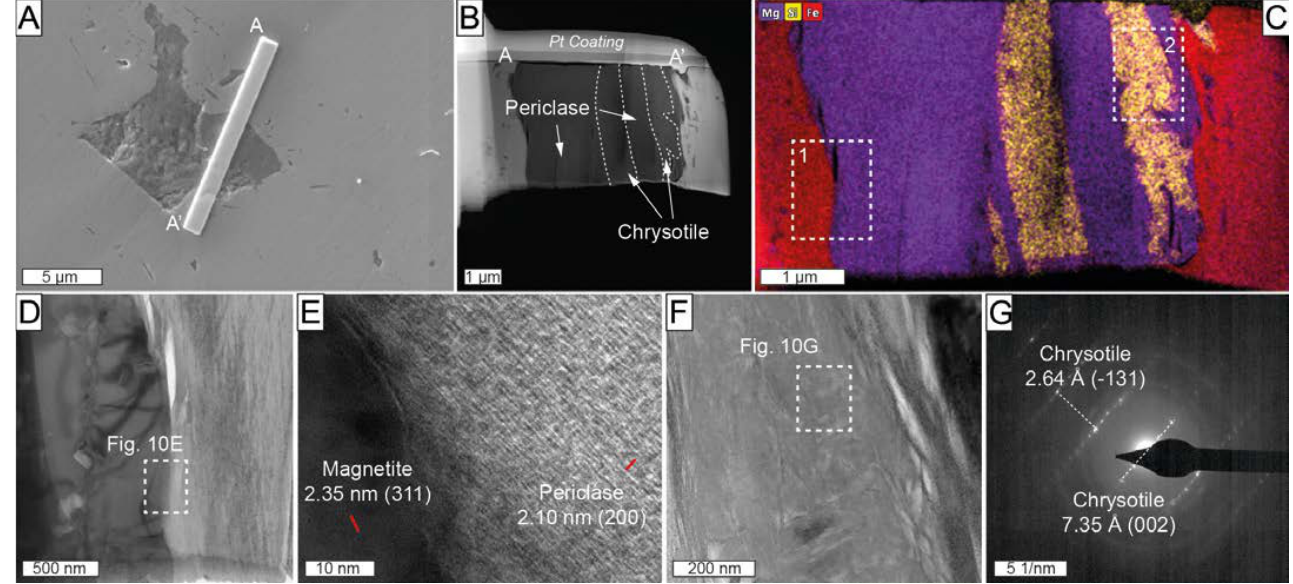
Figure 10. ( A ) Backscattered electron image including the location of thin-foil (A-A’) crosscutting composite inclusion in Mg-rich magnetite from the ludwigite–magnetite zone. Sample ROB-21; ( B ) high-angle annular dark-field scanning transmission electron microscopy (HAADF-STEM) image of A-A’ thin foil; ( C ) TEM-EDS elemental map for Mg (purple), Si (yellow), and Fe (red); ( D , F ) HAADF images of the area corresponding to rectangles 1 and 2, respectively, marked in ( C ); ( E ) high-magnification HRTEM image at the contact of the Mg-rich magnetite and periclase marked with a white rectangle in ( D ); ( G ) SAED of the serpentine marked with a white rectangle in ( F ).